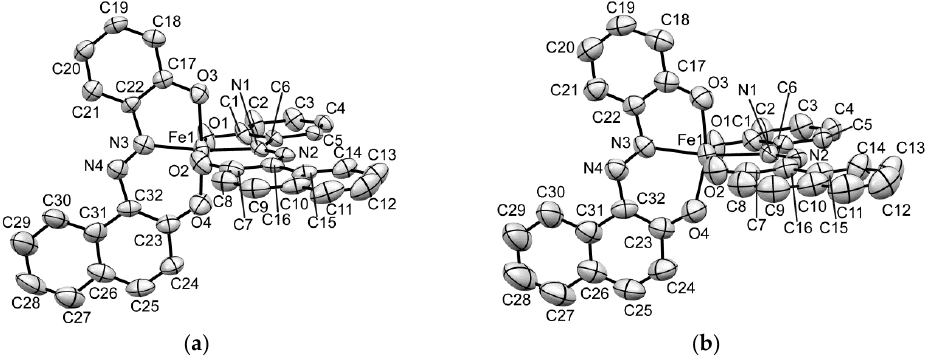
Figure 5. ORTEP drawings of 50% probability with atomic numberings for the [Fe(aznp) 2 ] anion in compound 1 . ( a ) At 90 K; ( b ) At 273 K. Hydrogen atoms are omitted for clarity. Table 3. Selected coordination bond lengths and distortion parameters for 1 , 2 , and 2’